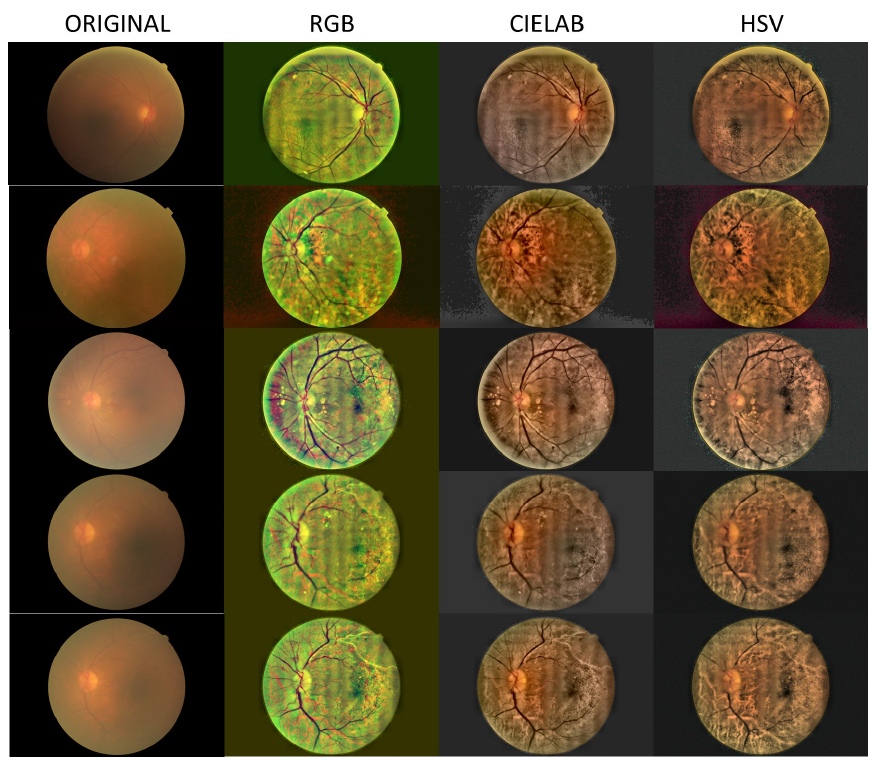
Figure 3. Processed images for the case of moderate cataract.